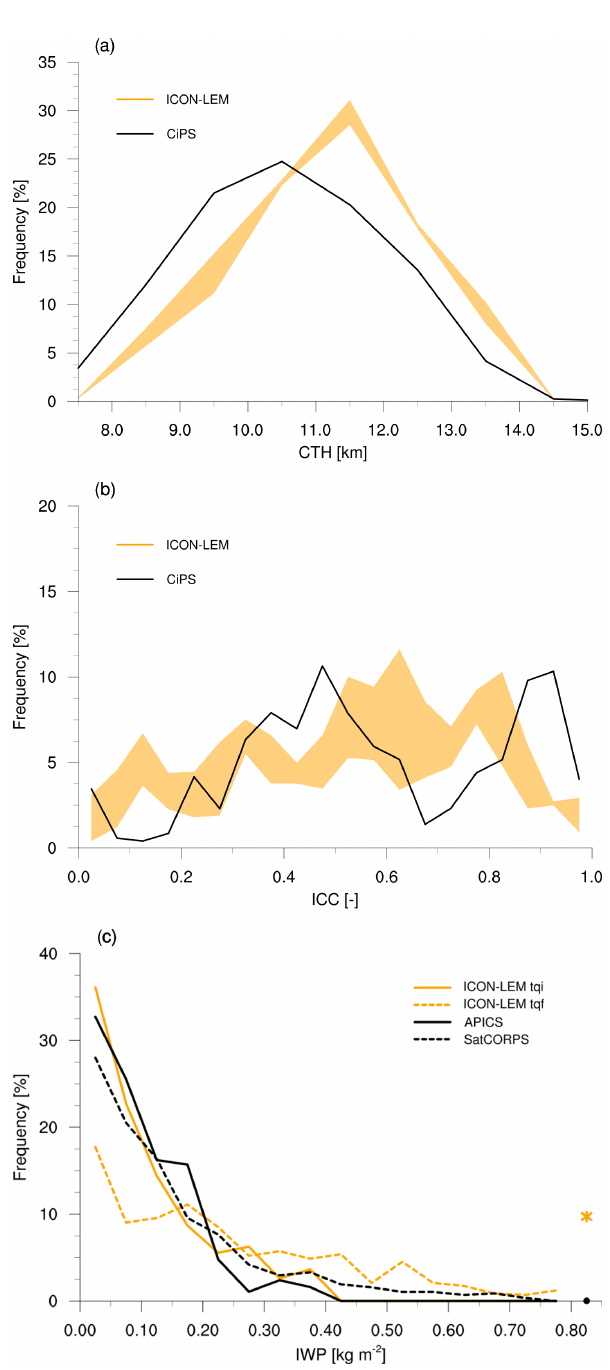
Figure 7. Histograms of cloud-top height CTH (a) , domain- averaged ice cloud cover ICC (b) , and IWP (with a bin size of 0.05) (c) for all simulated convective days listed in Table 1. The observational CiPS data set is used as a comparison for CTH and ICC, while APICS and SatCORPS are used for IWP. Simulated and observed IWP data are restricted to daytime values between 06:00 and 17:30UTC due to the limitation of APICS to sunlit hours. In (c) the orange star indicates accumulated frequencies with simu- lated tqf larger than 0.8kgm − 2 , and the black dot shows the ac- cumulated frequency of ICON-LEM tqi and of both observational IWP